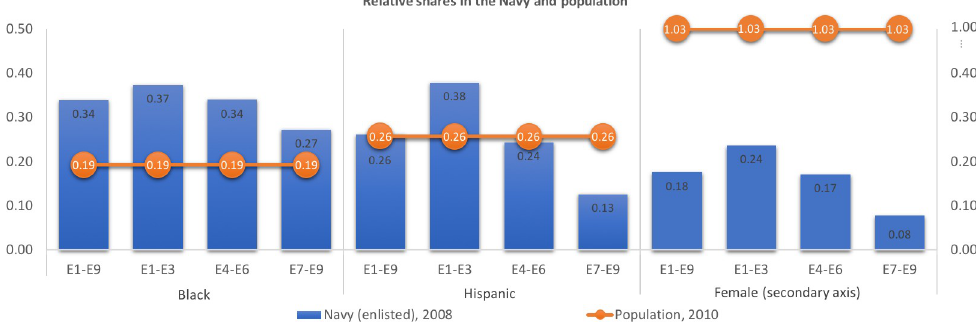
Fig 1. The relative frequencies of minorities in the population (2010 census) and in the Navy